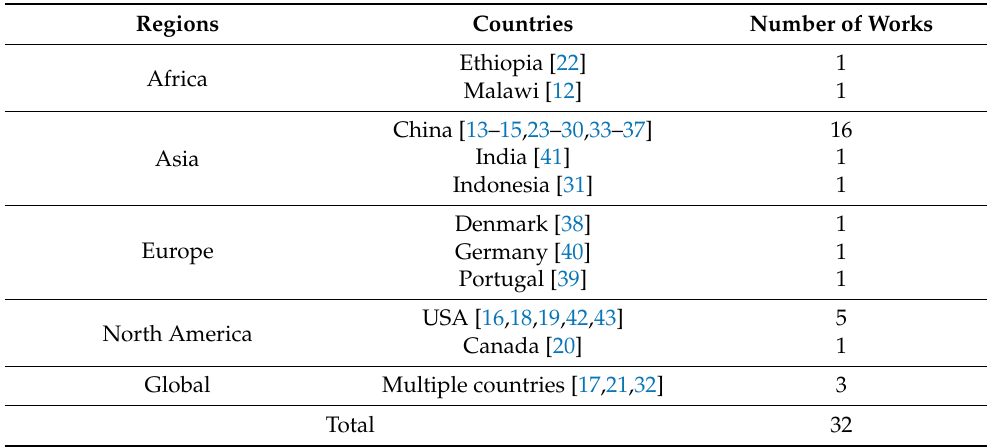
Table 2. Study areas by global